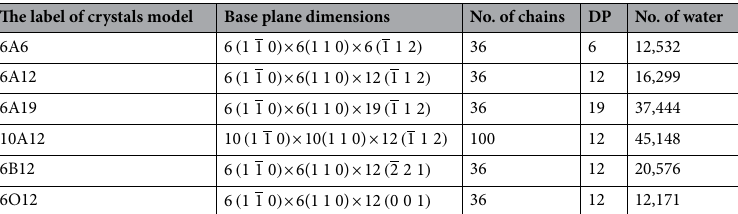
The label of crystals